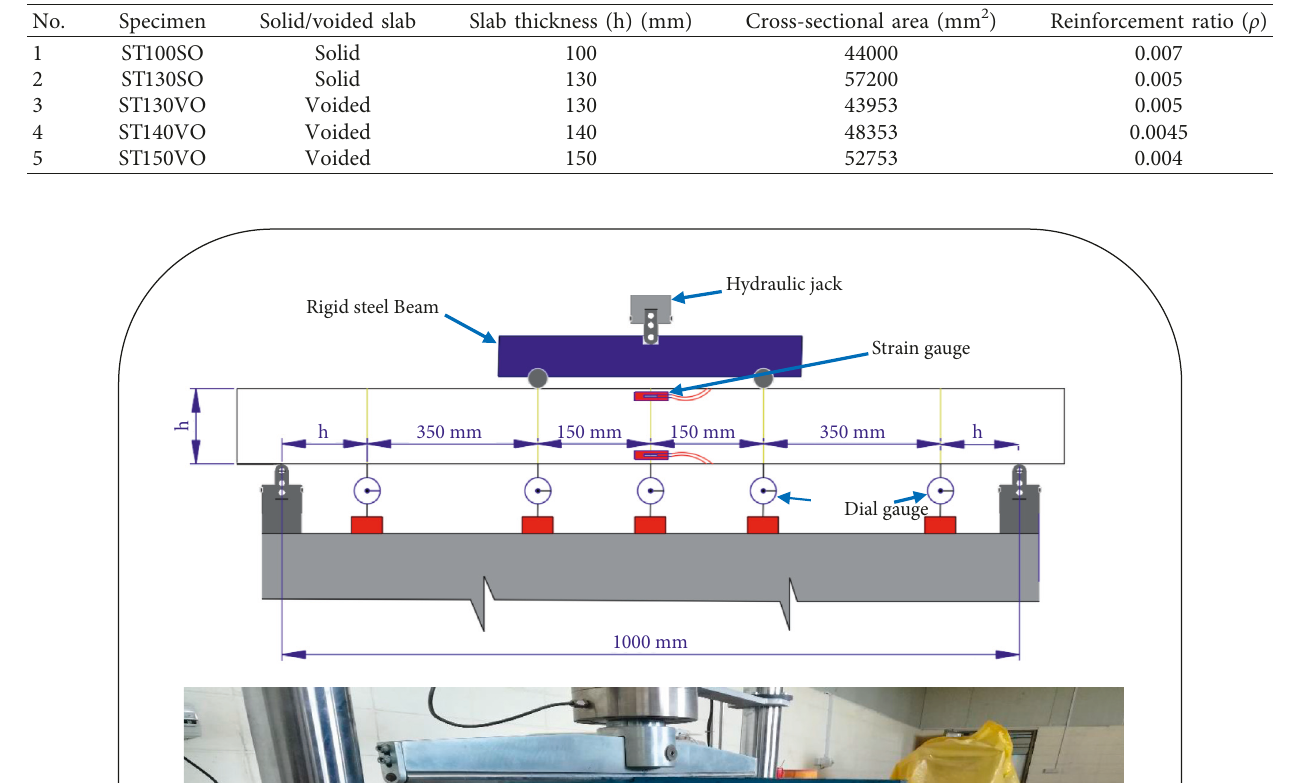
Table 2: Details of specimens.